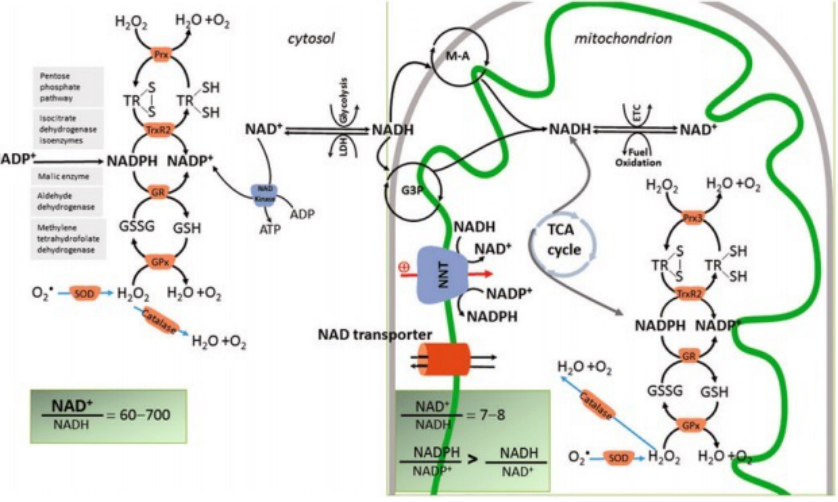
Fig. 5 Schematic diagram of energy